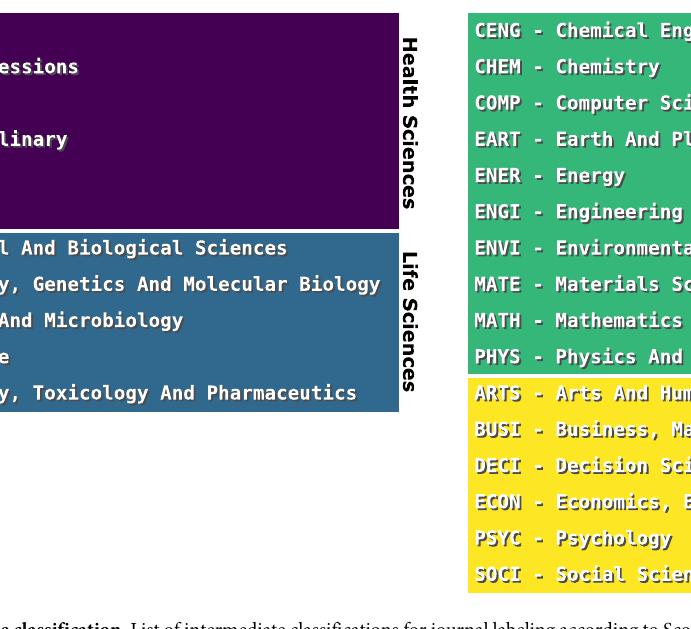
PLOS ONE | https://doi.org/10.1371/journal.pone.0248724 March 18,